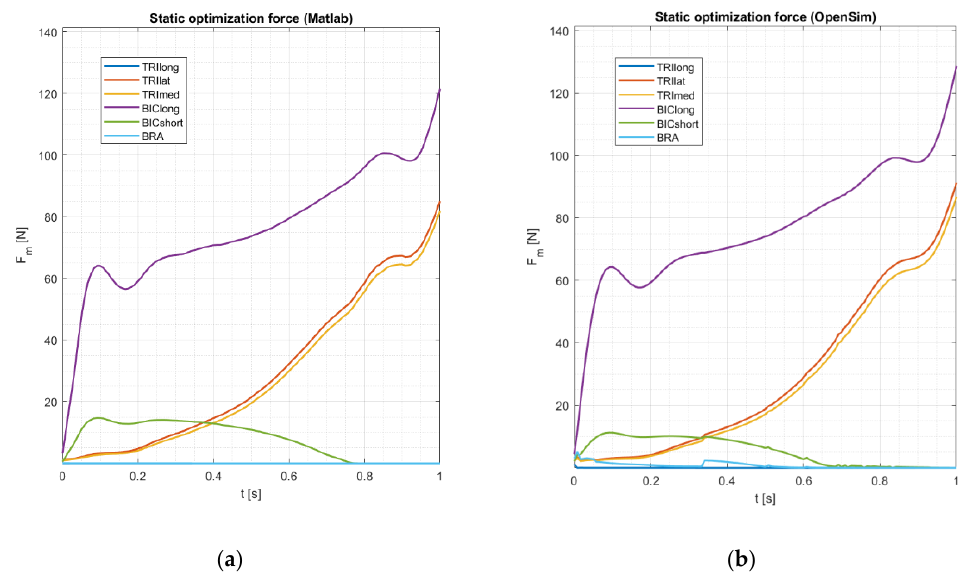
Figure 16. Muscles’ forces with physiological criterion and no passive forces: ( a ) Matlab and ( b ) OpenSim.